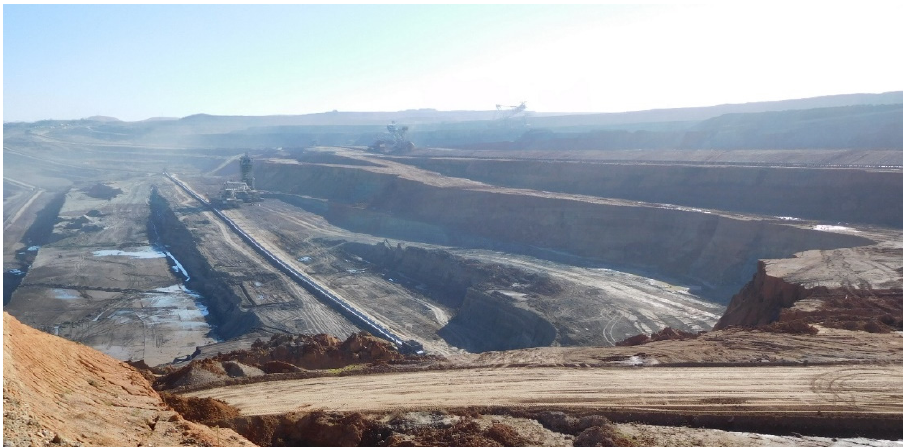
Figure 1. Typical exploitation of surface lignite mines in Greece using large bucket-wheel excavators and conveyor belts. The photo (taken in 2016) shows the SW exploitation front (average slope inclination about 1:6) of the recently decommissioned ca. 200 m deep Amyntaion mine.